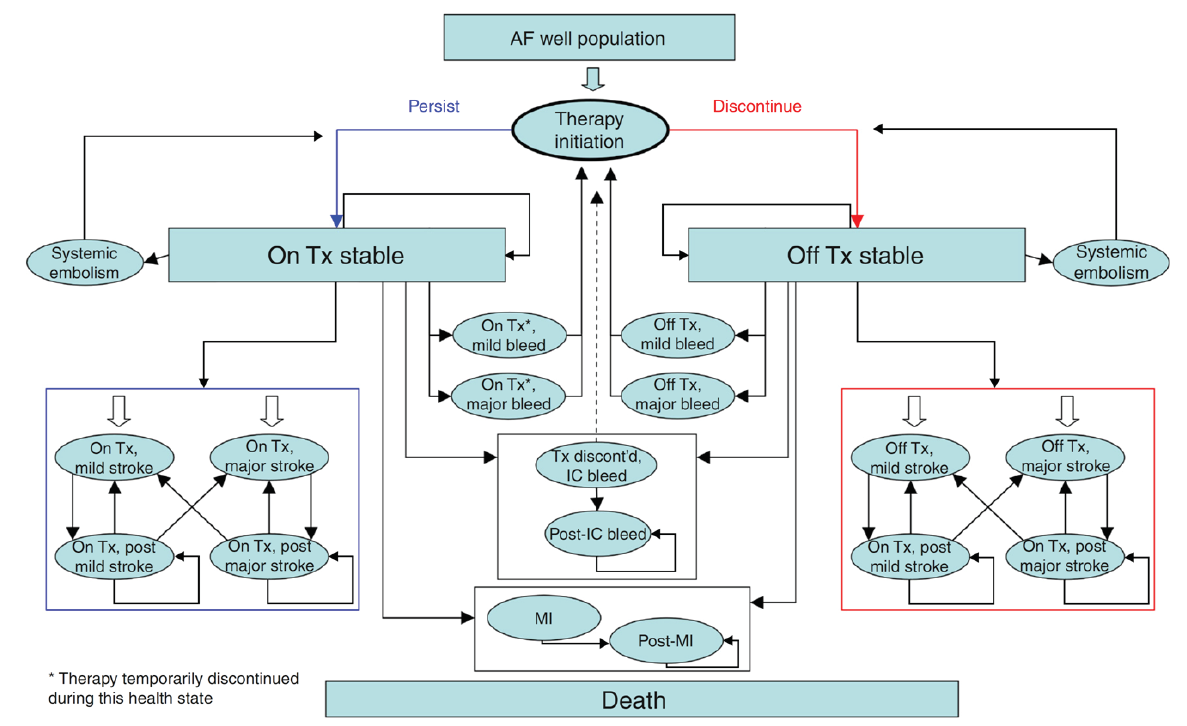
Figure 1. Overall Model Structure